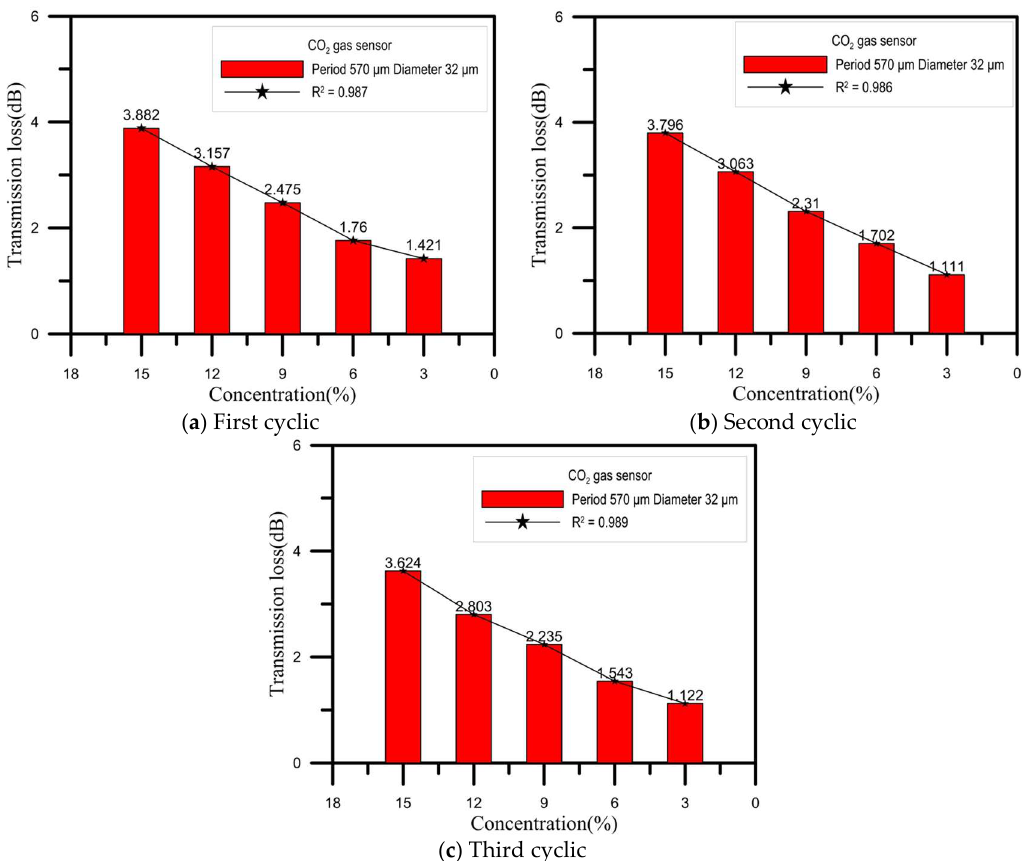
Figure 11 . Response characteristics of sensing for the 15%, 12%, 9%, 6%, and 3% CO 2 gas concentrations over three cyclic experiments. ( a ) First cyclic; ( b ) second cyclic; ( c ) third cyclic.